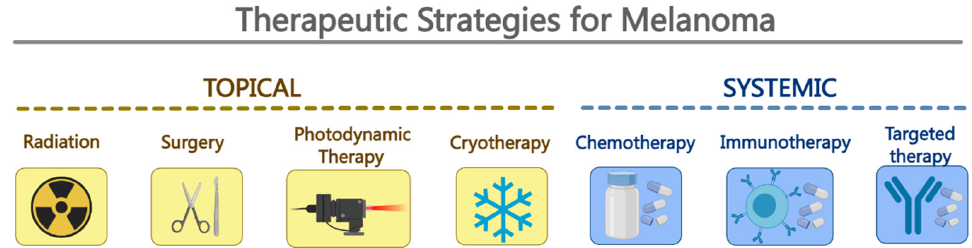
Figure 1. Therapeutic strategies for melanoma (this figure was created with MedPeer http://image.medpeer.cn/).